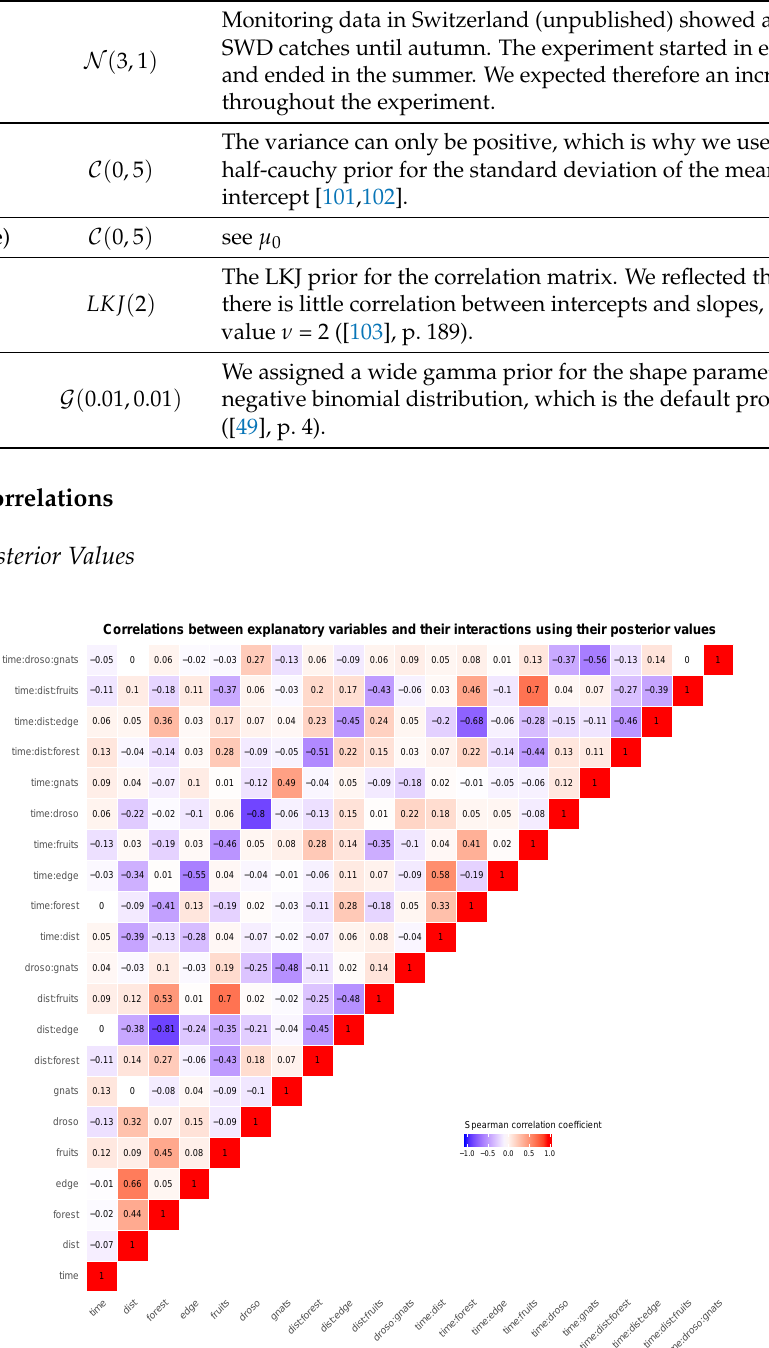
Figure A2. Spearman correlation coefficients between explanatory variables using posterior